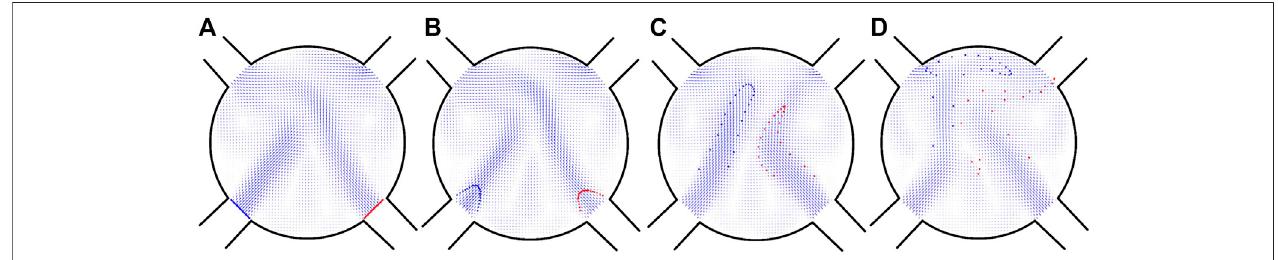
FIGURE 7 | Injection of particles over the velocity fi eld in one NETmix